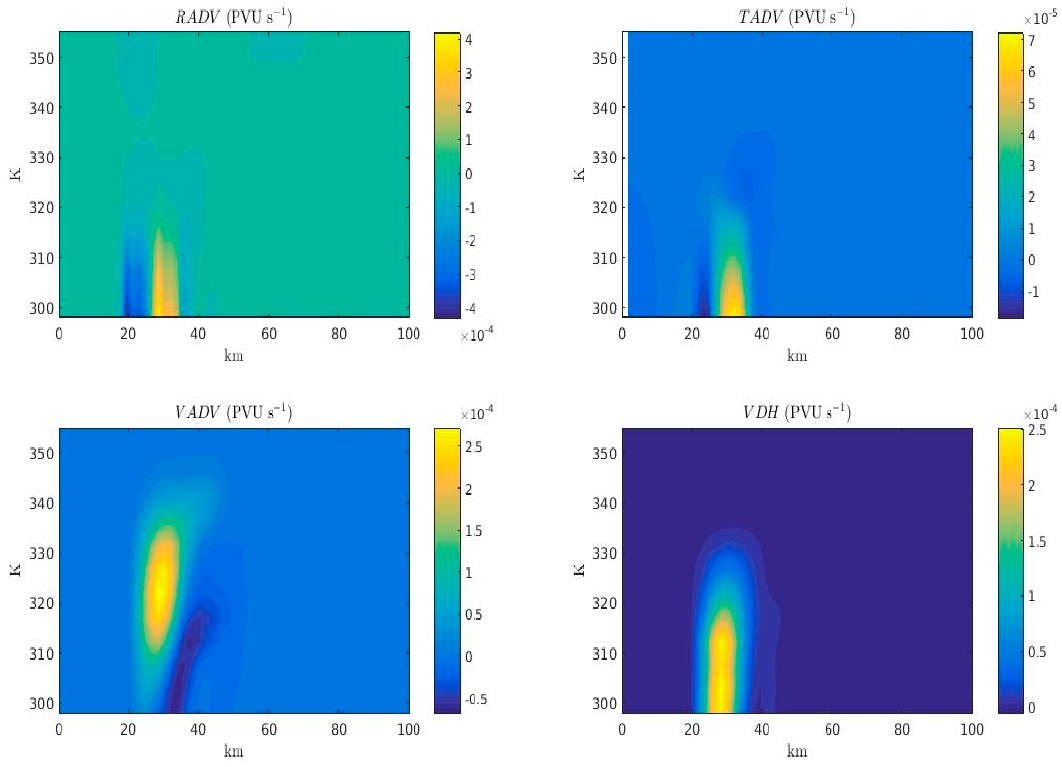
Figure 8. Same as Figure 7, except for (cid:1872) = 9